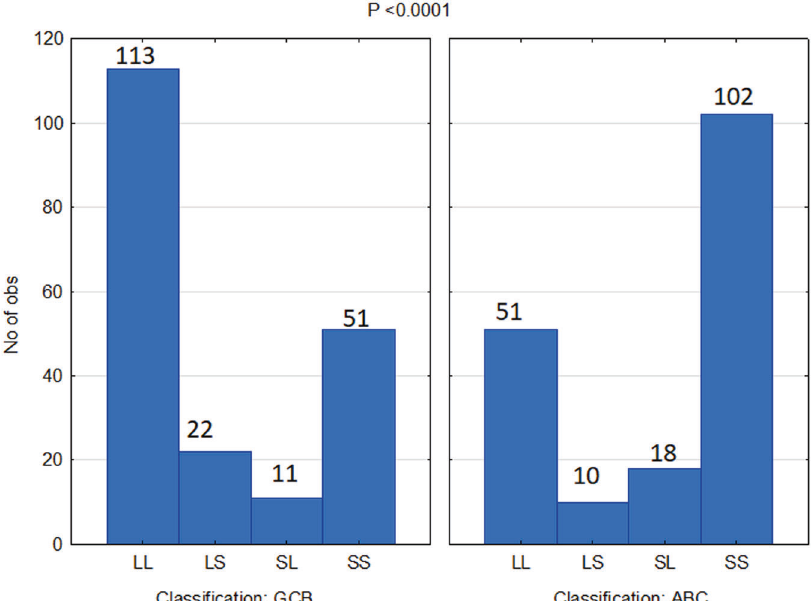
Fig. 4 Correlation between survival groups and cell of origin classi fi cation. The left panel shows that majority of patients classi fi ed as germinal center B-cell-like (GCB) are classi fi ed as having long survival (LL) on the survival model. The right panel shows that majority of patients classi fi ed as activated B-cell-like (ABC) are classi fi ed as having short survival